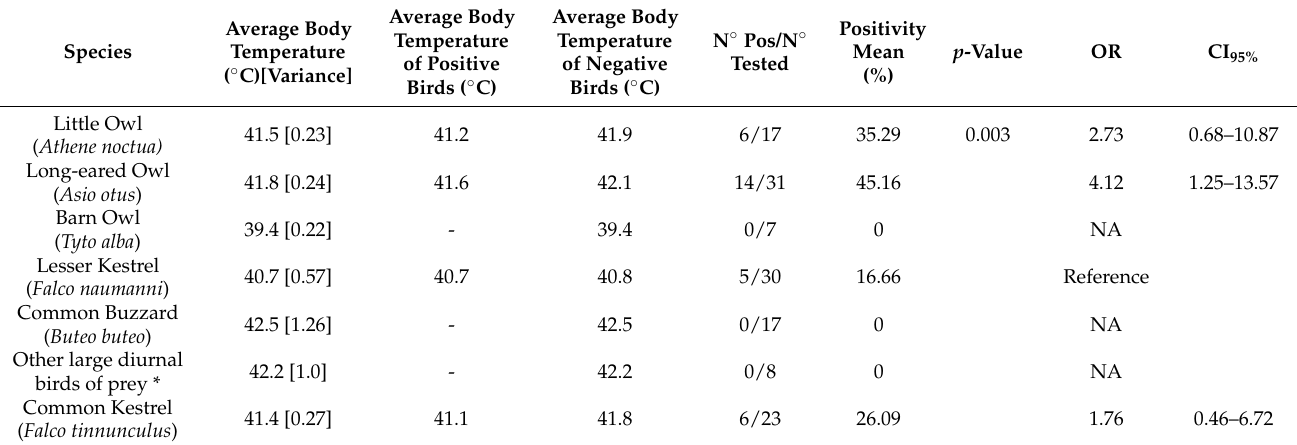
Table 7. Average body temperature of wild birds and Campylobacter